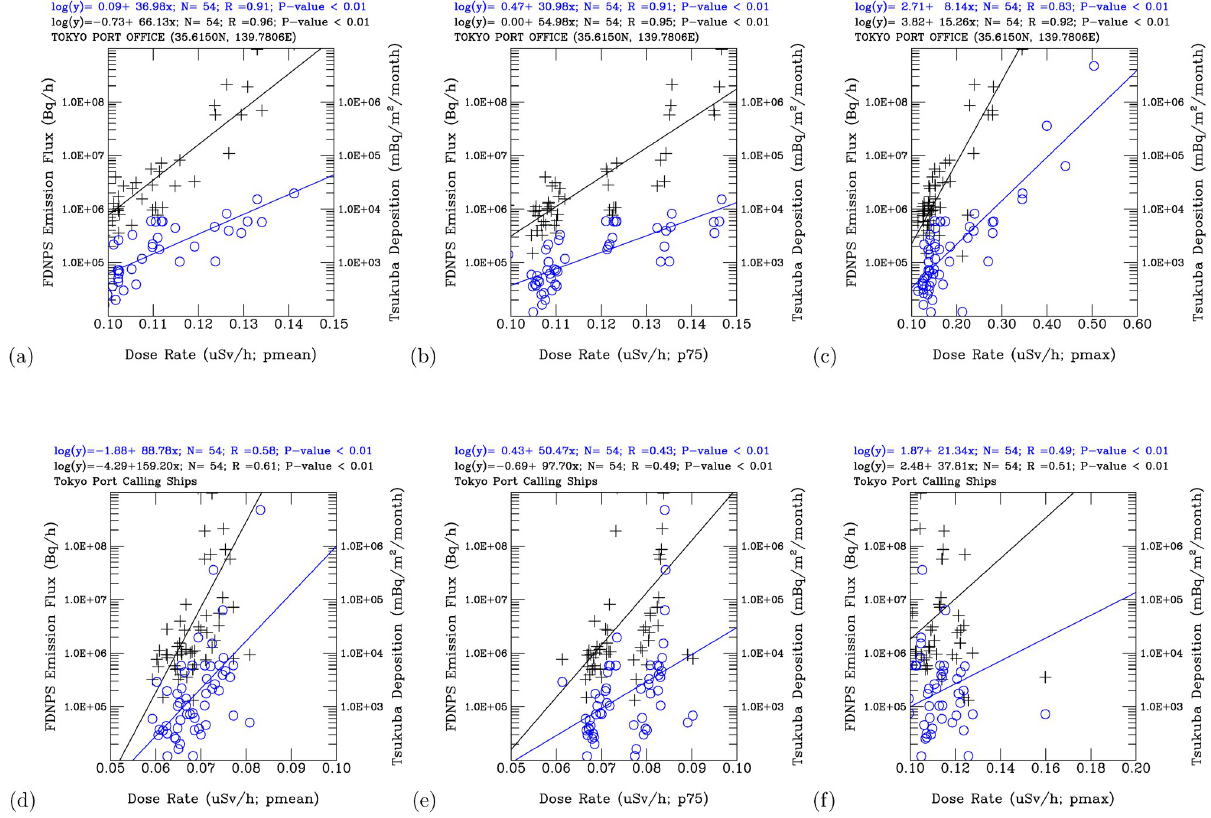
Fig 7. Scatter plot analysis of the FDNPS radiocesium emission fluxes (black crosses) and measured Tsukuba radiocesium deposition fluxes (blue circles) versus the monthly mean (pmean), 75 th percentile (p75), and maximum (pmax) air dose rates. Port of Tokyo office: (a) pmean (b) p75 and (c) pmax. Port of Tokyo calling ships: (d) pmean, (e) p75 and (f)